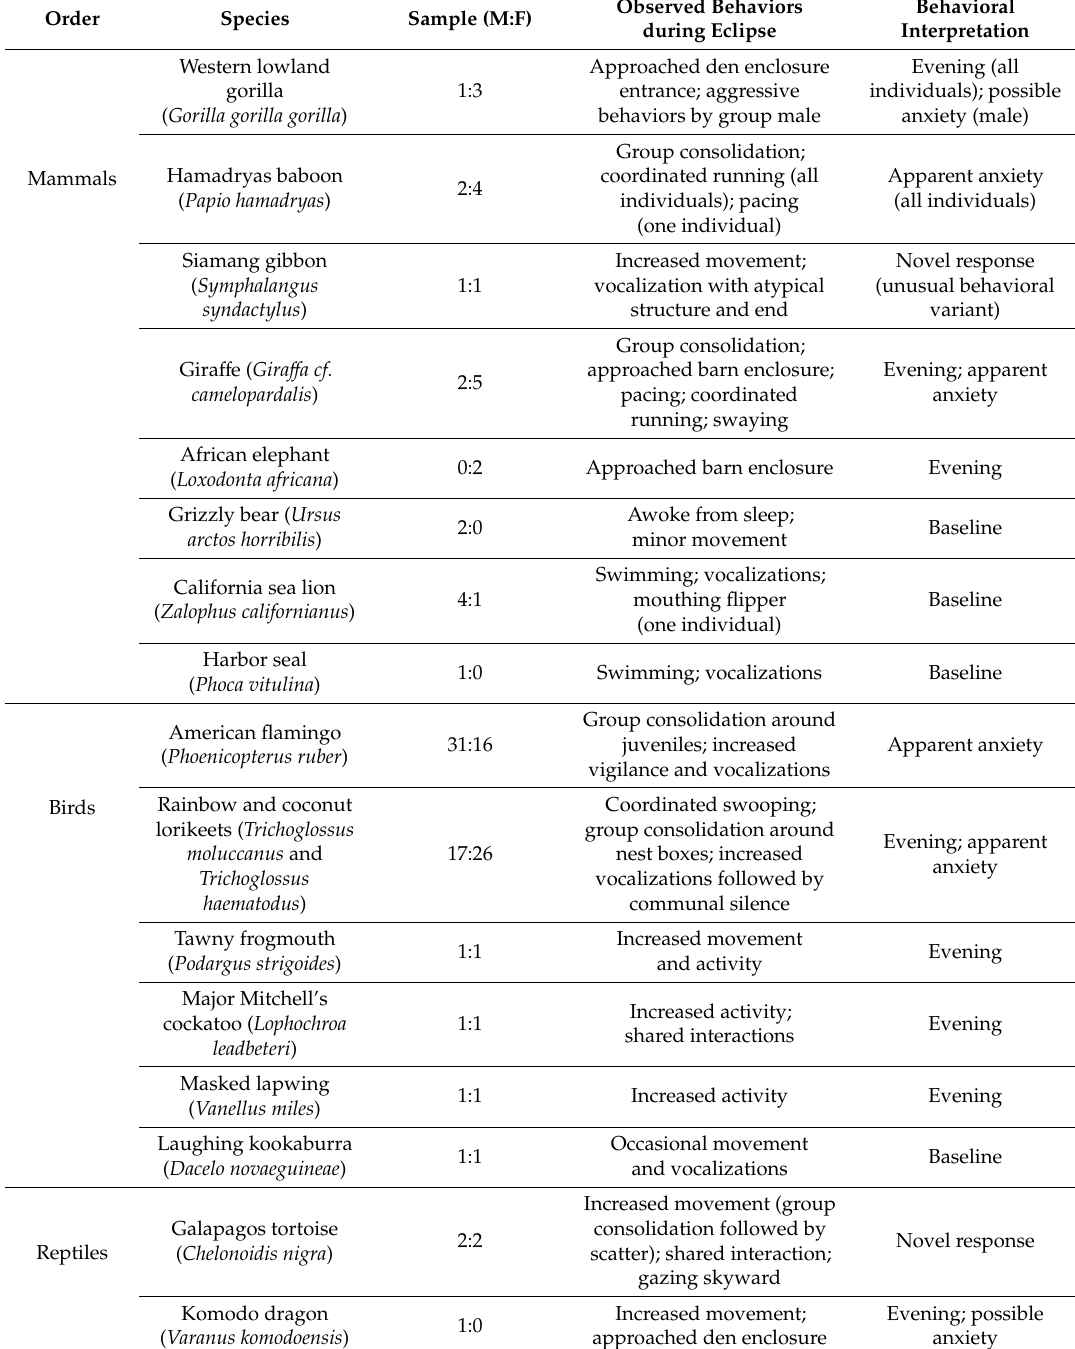
Table 2. Focal taxa observed during the 2017 total solar eclipse. Behavioral observations among focal taxa during the total solar eclipse. Behaviors are classified into one of four overarching categories: evening / nighttime response, apparently anxious response, novel response, or no response (e.g., behaviors indistinguishable from baseline